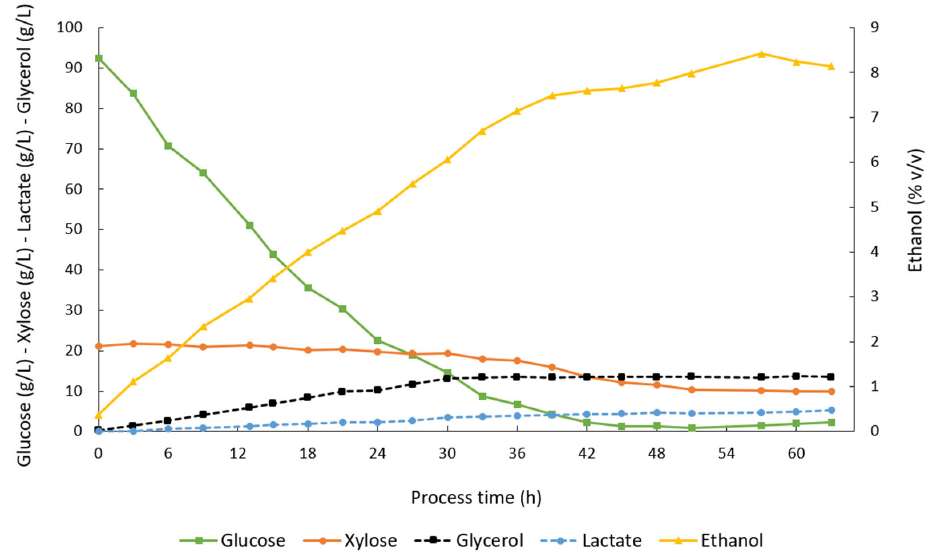
Figure 7. Course of the SSF at 2 m 3 scale, demonstrated on a real cardboard and paper waste stream .